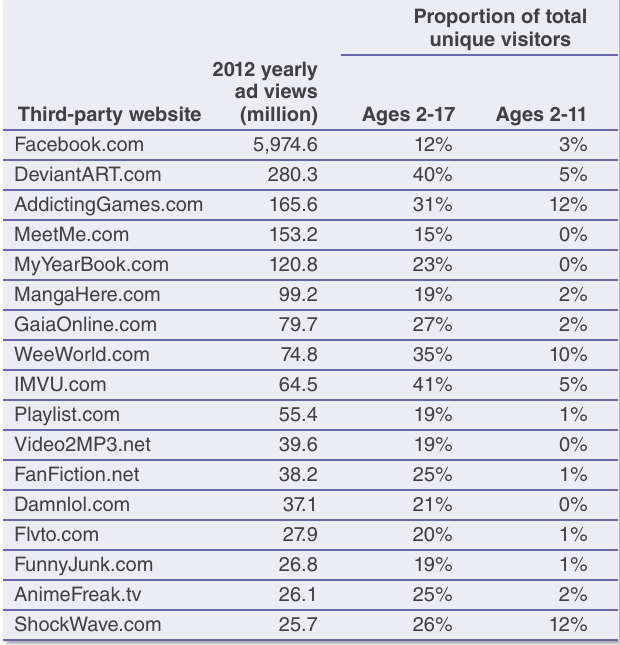
Table 30. Ad views on Facebook and top third-party youth